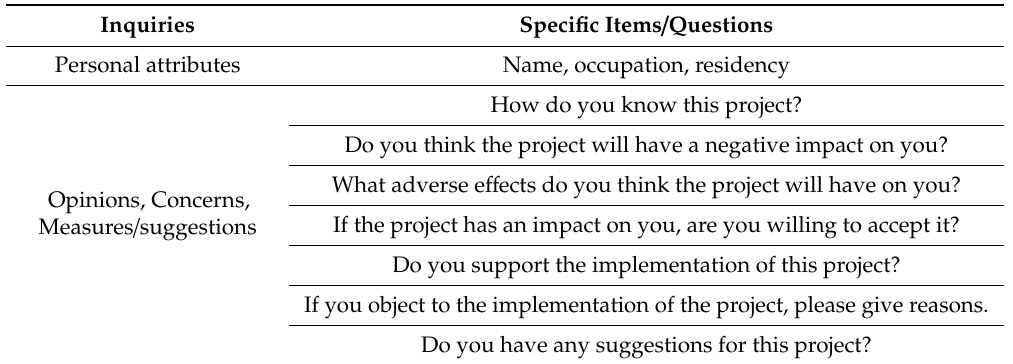
Table 1. Some main questions for the questionnaire.